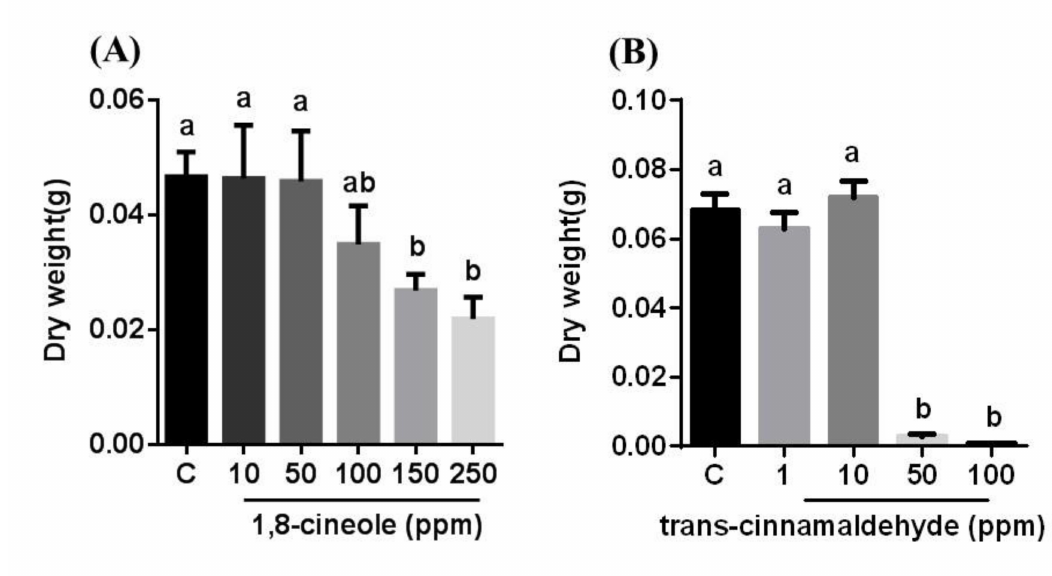
Figure 1. Effects of ( A ) 1,8-cineole and ( B ) t -cinnamaldehyde on the growth of Aspergillus flavus . Different letters above the same column indicate significant differences among the treatments. Data are presented as the mean ±